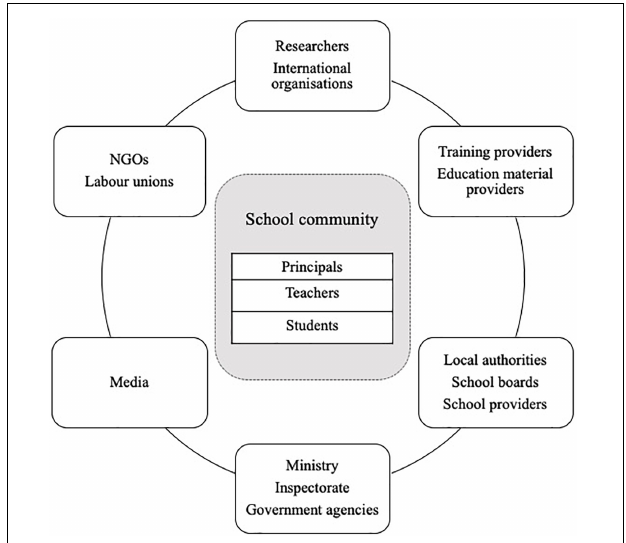
FIGURE 1 | Stakeholders in education. Adapted from Burns and Köster